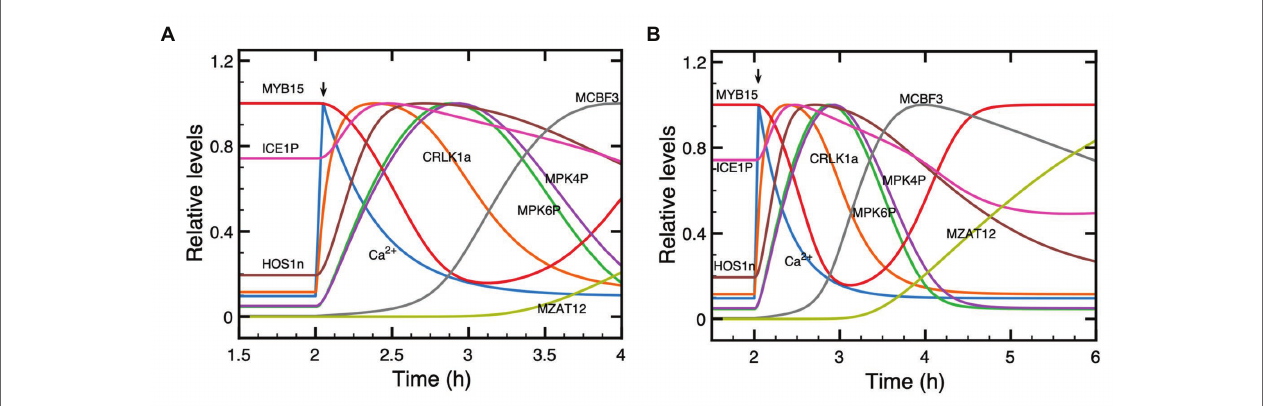
FIGURE 3 | Dynamics of the cold response pathway during the first 2 h (A) or 4 h (B) after a cold stress. Shown is the time evolution of Ca 2+ , CRLK1 a , ICE1P, HOS1n, MPK6P, MPK4P, MYB15, CBF3 mRNA, and ZAT12 mRNA. The cold signal elicits at t = 2 h a transient Ca 2+ pulse (blue curve). Before the pulse, all state variables are at their stable steady state. To distinguish more clearly the relative positions of the different curves, each plotted state variable was normalized through division by the maximum it reaches in the course of time, since absolute levels would make it difficult to follow the order of peaks and troughs. Parameter values are the same as in Figure 2 where the time evolution is shown separately for each variable on a longer time